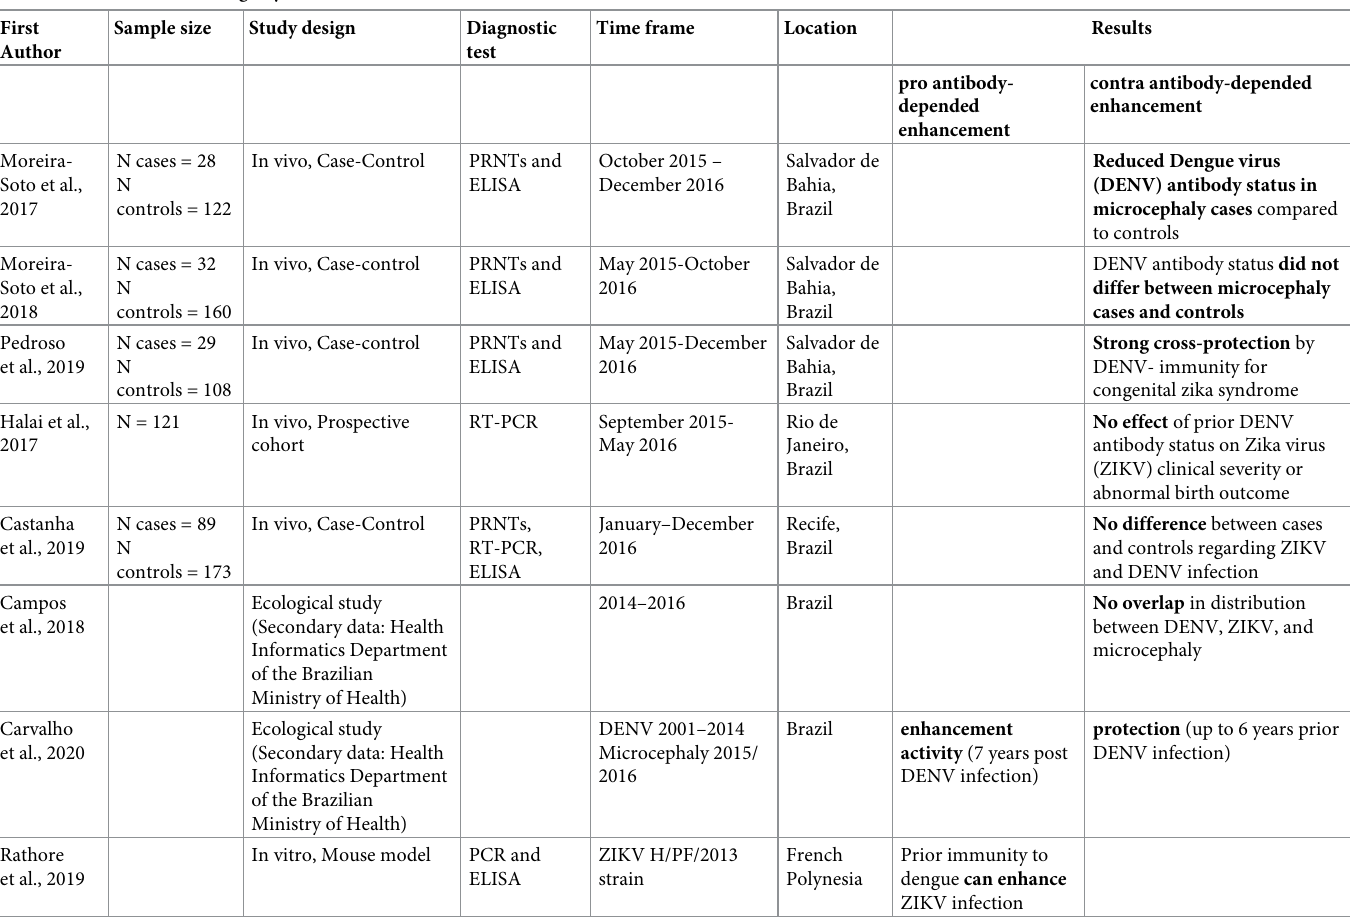
Table 1. Listed studies through Systematic